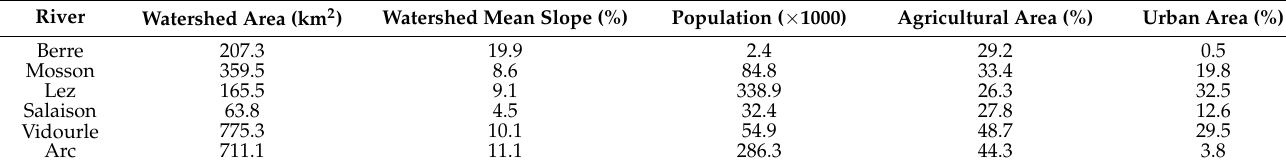
Table 1. Mains features of the studied watersheds.